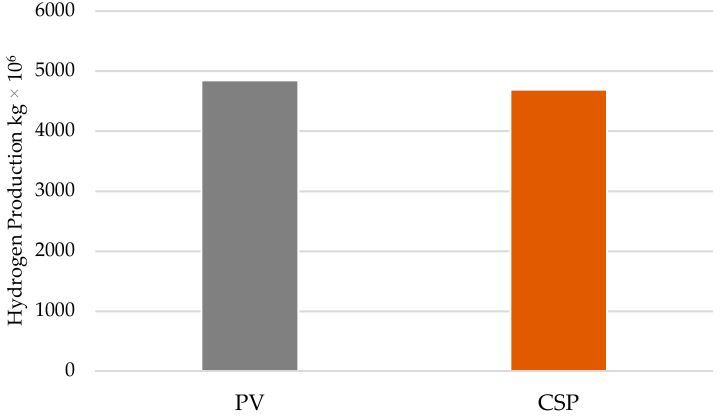
Figure 7. Second pathway GIS analysis results for closest ports and shortest electrical grid routes for electricity transmission from solar plants to port sites.